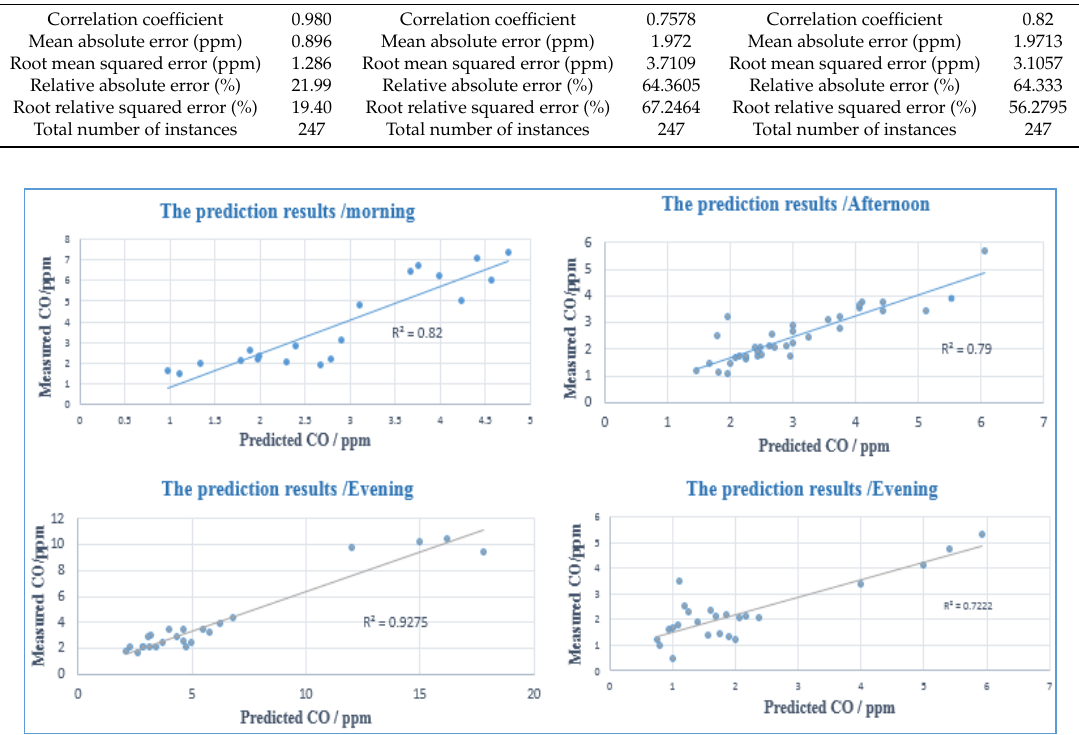
Figure 8. Accuracy assessment of the predicted maps (morning, afternoon, evening and night).